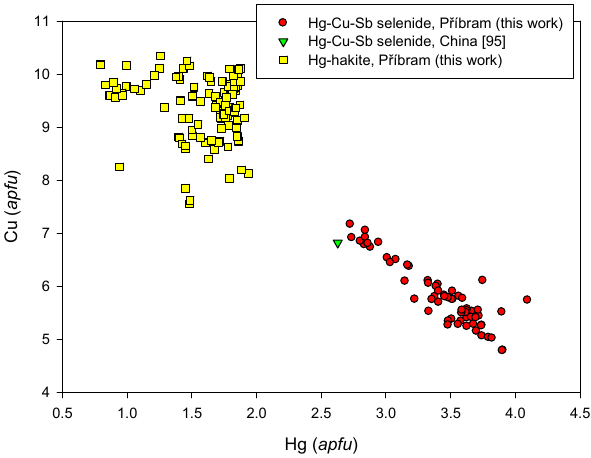
Figure 66. Hg vs. Cu ( apfu ) graph for unnamed Hg-Cu-Sb selenide and Hg-hakite.